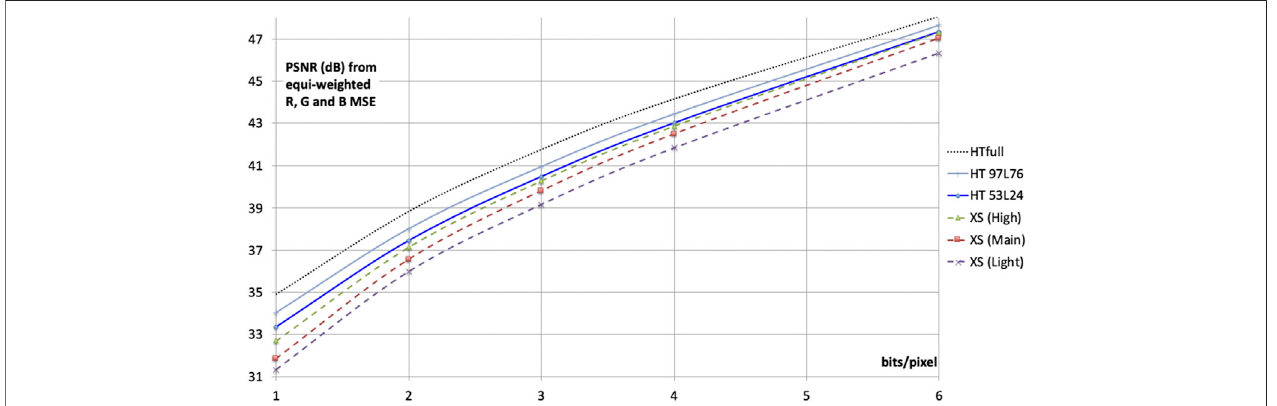
FIGURE11| Rate-distortionperformanceofHTJ2Kover10RGB4:4:4testimagesinlowlatencycon fi gurations,withfundamentalend-to-endlatenciesof24lines (HT 53L24 has two levels of vertical 5/3 DWT) and 76 lines (HT 97L76 has three levels of vertical 9/7 DWT), compared with JPEG-XS and with full-frame (i.e., not low- latency) HTJ2K (5 levels of 9/7 DWT). Fundamental latencies exclude computation time, which may increase the end-to-end latency by up to 50% in a typical hardware implementation. According to Annex E of ISO/IEC 21122-2:2018, the Light, Main and High pro fi les of JPEG-XS have 2, 10 and 20 video lines of latency